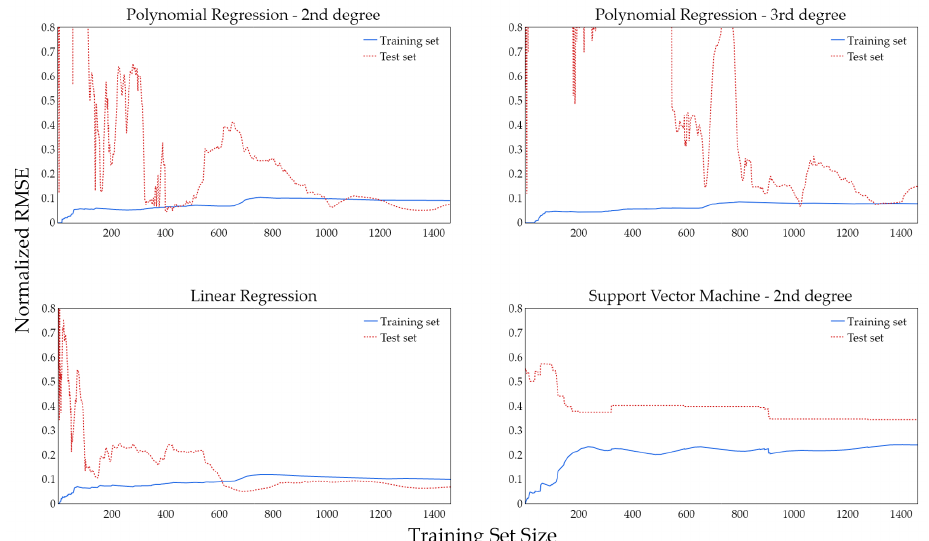
Figure 10. Learning curves of proposed models for 1st DCT frequency component (latitude: 22.5 ◦ S, longitude: 180 ◦ E).